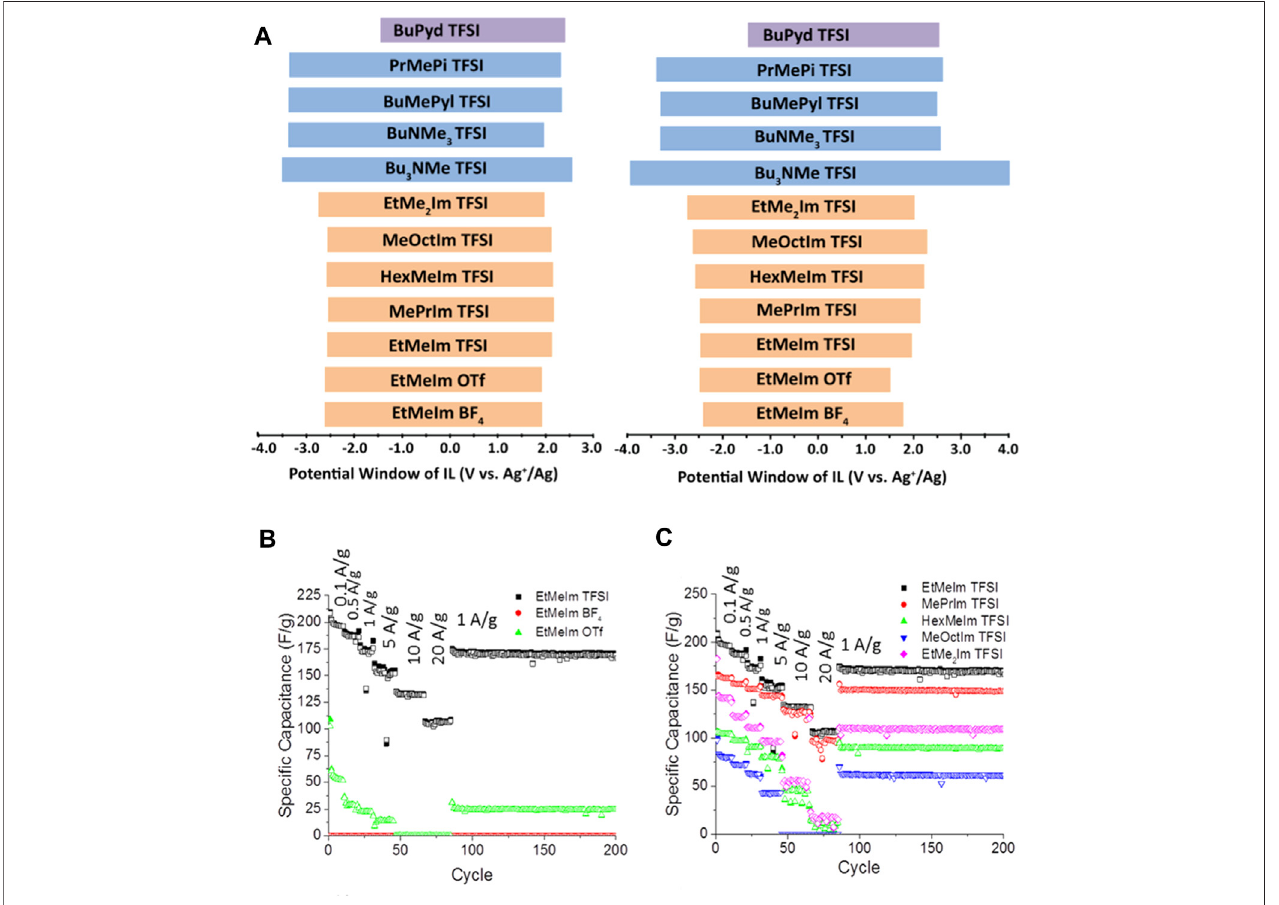
FIGURE 6 | effect of; (A) alkyl chain length on the electrochemical stability window, (B) anion, (C) alkyl spacer length on the speci fi c capacitance values at various rates for mesoporous carbon electrodes using the IL electrolytes. Reprinted with permission from (Mousavi et al., 2016), American Chemical society.